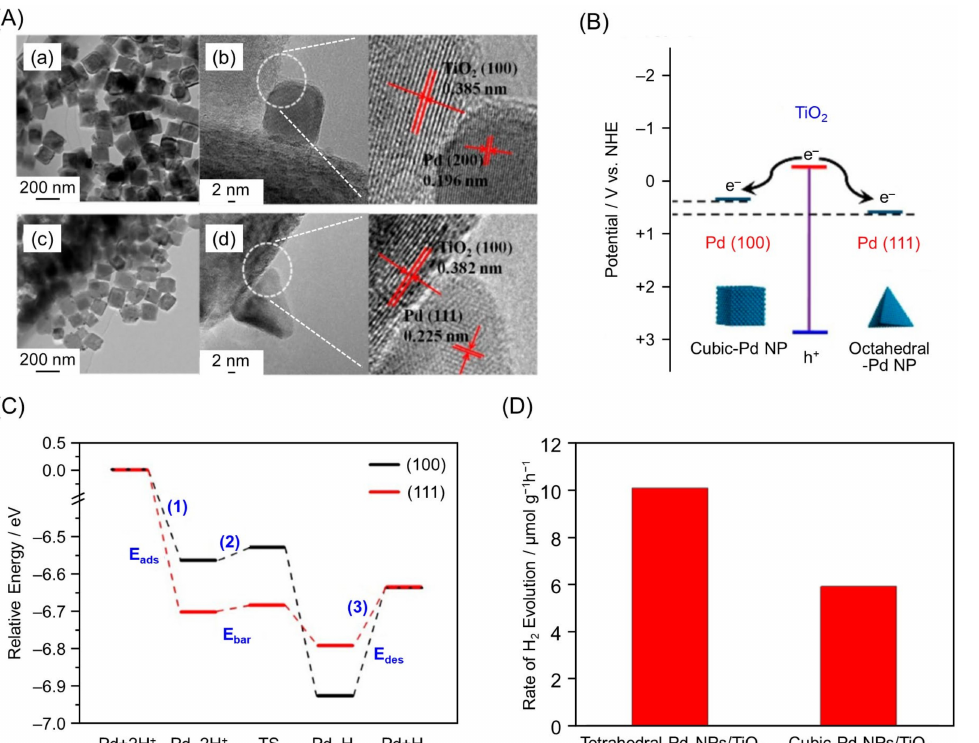
Figure 24. ( A ) TEM images of ( a ) cubic-Pd NPs/TiO 2 and ( c ) tetrahedral-Pd NPs/TiO 2 samples, and HR-TEM images of ( b ) cubic-Pd NPs/TiO 2 and ( d ) tetrahedral-Pd NPs/TiO 2 samples. ( B ) Schematic illustration of photogenerated electron transfer from the CB of TiO 2 to the Pd (100) and Pd (111) surface. ( C ) Energy variation in the H 2 evolution process on Pd (100) and Pd (111) facets. The total energy of the initial Pd surface and two isolated H atoms is set to zero. Parenthesized numbers indicate the three reaction steps. TS represents the transition state. E ads , E bar , and E des are the adsorption energy of H atoms, energy barrier, and desorption energy of the H 2 molecule, respectively. The calculated E abs , E bar , and E des of Pd (100) facets are − 6.57, 0.034, and 0.29 eV, respectively, and those of Pd (111) facets are − 6.77, 0.018 and 0.16 eV, respectively. ( D ) Photocatalytic H 2 evolution activities of tetrahedral-Pd NPs/TiO 2 and cubic-Pd NPs/TiO 2 from 10 vol% lactic acid solution under Vis-light irradiation ( λ > 420 nm). Reproduced with permission from reference [222]. Copyright 2018 American Chemical